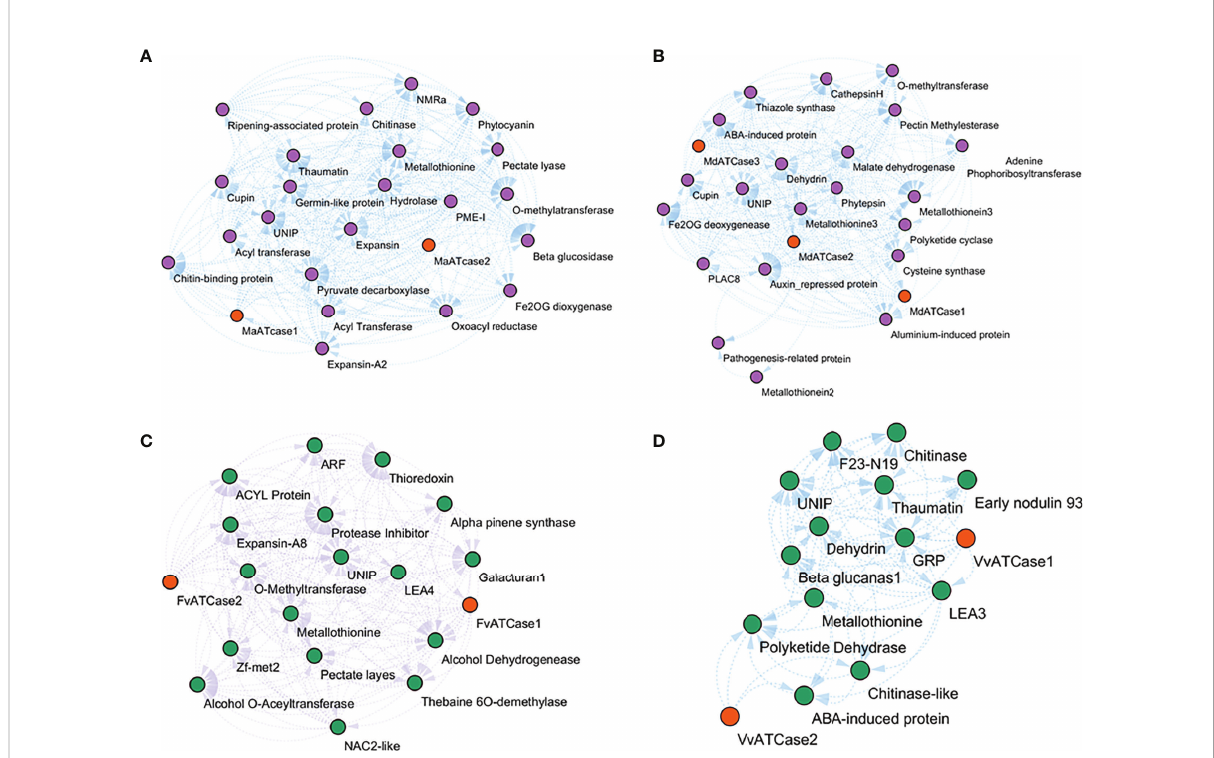
FIGURE 7 Relative co-expression network of aspartate and ornithine carbamoyltransferase genes during fruit ripening condition in banana (A) , apple (B) , grape (C) , and strawberry (D)